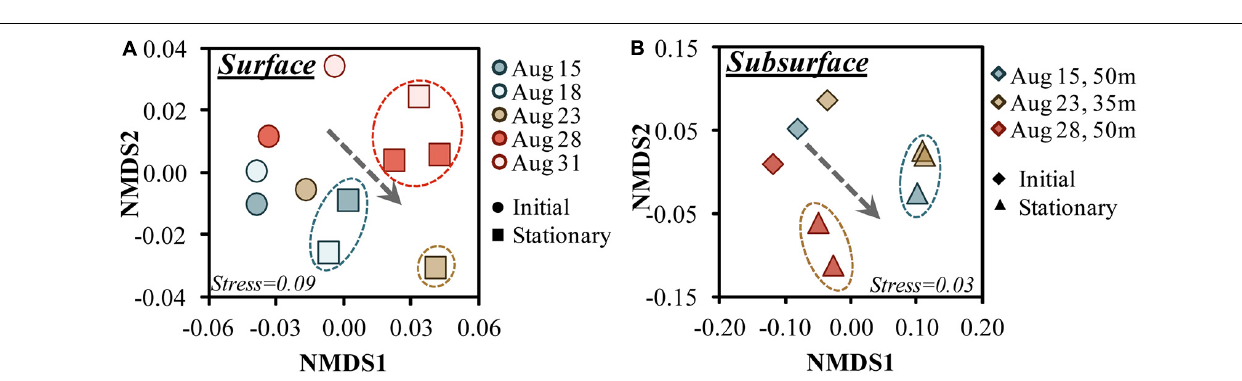
FIGURE 5 | Non-metric multidimensional scaling (nMDS) ordination plots of the 16S rDNA amplicon sequence variants for the surface (A) and subsurface (B) OM remineralization experiments between initial and stationary growth phase. Circles around stationary phase samples identify those samples that grouped significantly ( p > 0.01) based on SIMPROF analysis (Clarke et al., 2008); the dotted arrow illustrates the general trend between initial and stationary growth phases toward the positive nMDS1 region. Note that the 95 m communities, though available, were not included in the subsurface figure as it would have obfuscated initial/stationary trends shown for other